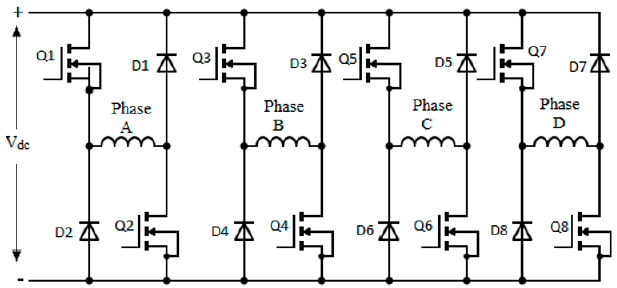
Figure 3. SRM four asymmetric